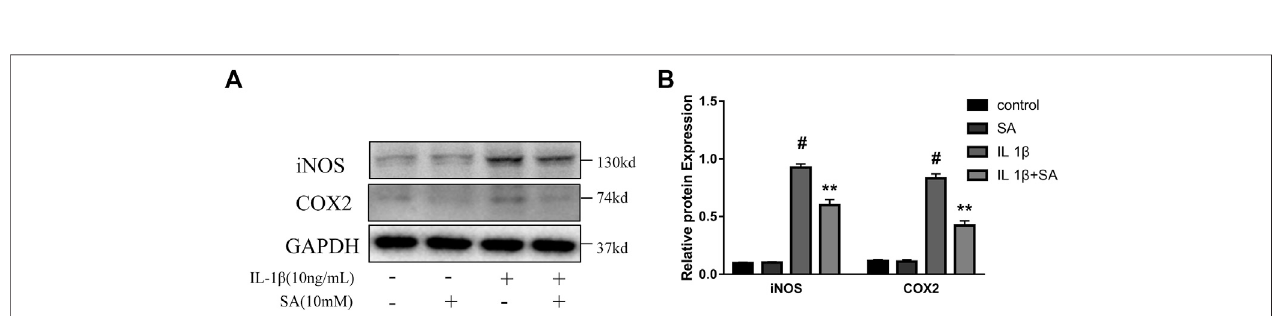
FIGURE2| SAamelioratesIL-1 β -inducedexpressionofiNOSandCOX2inSW1353cells.Representativewesternblotsandquanti fi cationdatashowingiNOSand COX2 expression in cells treated as described above. The data are shown as the mean ± SD ( n (cid:2) 3). # p < 0.05 vs. the control group; ** p < 0.01 vs. the IL-1 β group.